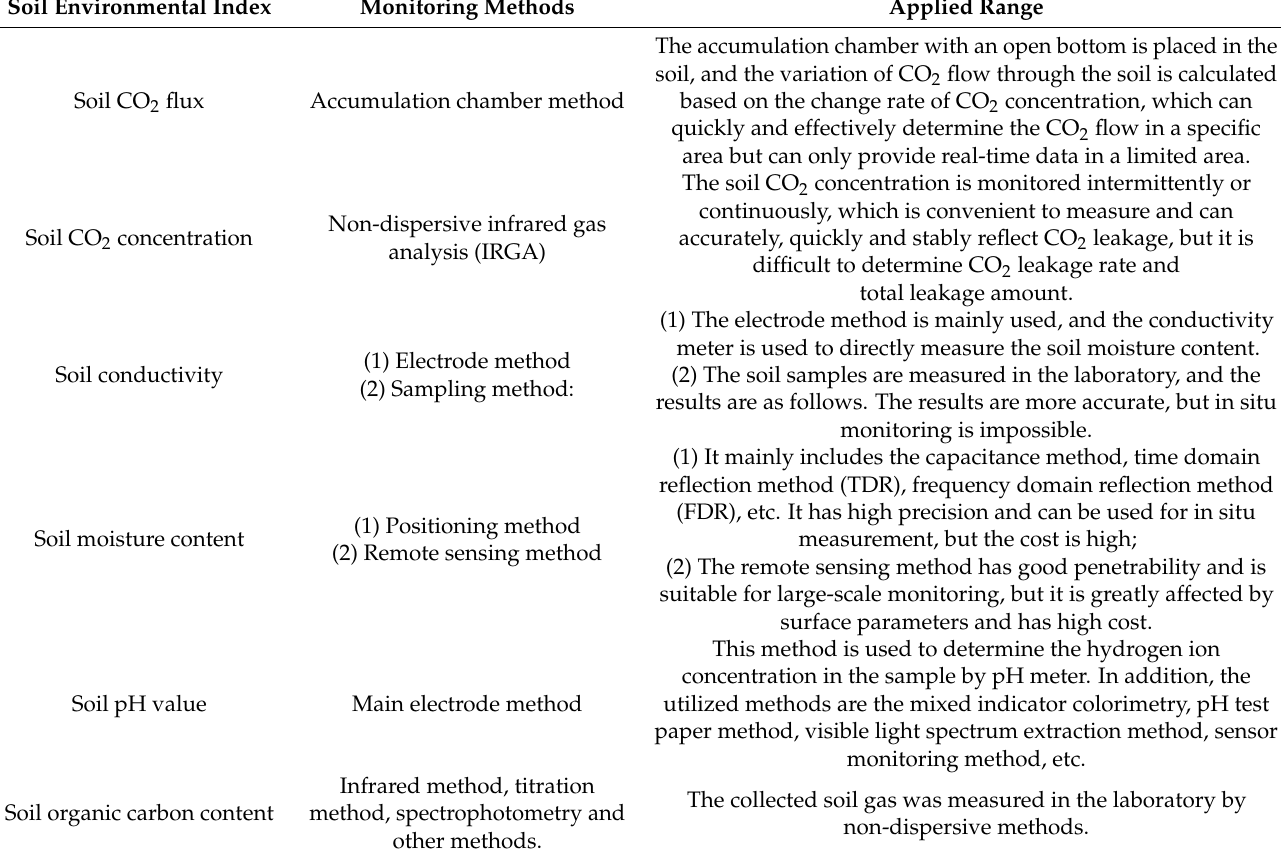
Table 3. Main environment indicators and monitoring methods for CO 2 leakage in soil